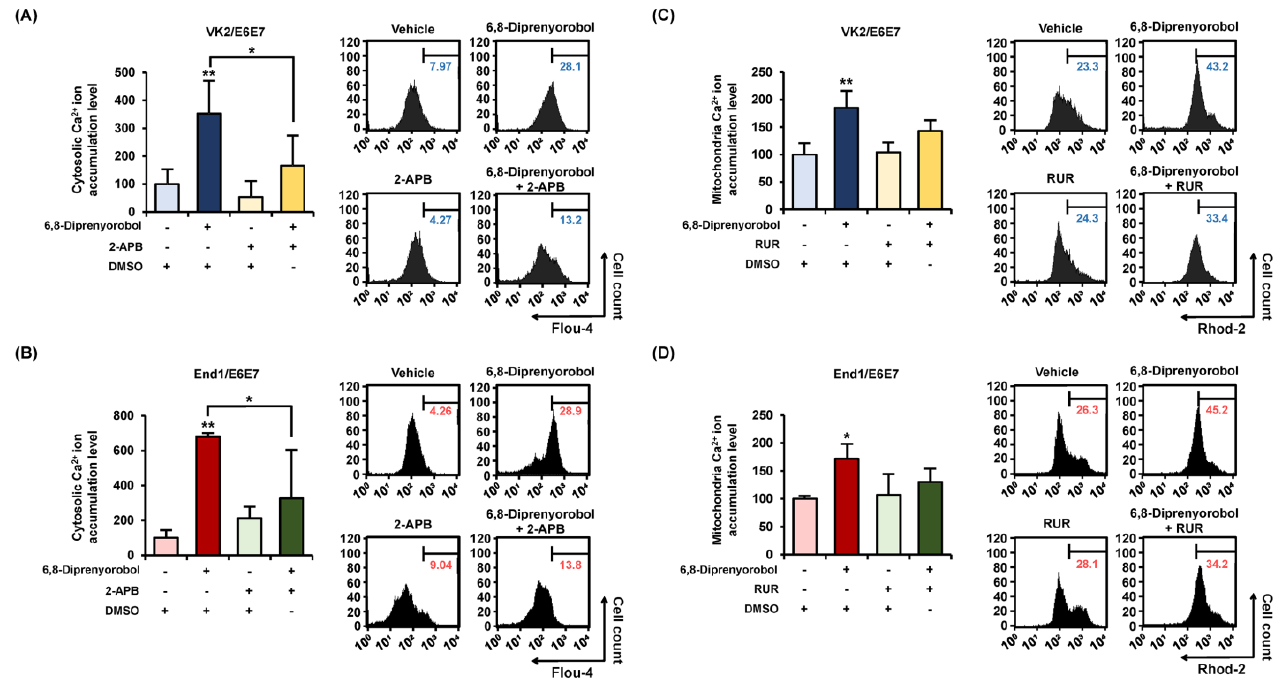
Figure 4. Alleviation effects of 6,8-diprenylorobol on disrupting calcium homeostasis in VK2/E6E7 and End1/E6E7. For 48 h, 6,8-diprenylorobol (2 μM) was treated with or without a calcium inhibitor (2-APB, 5 μM; and ruthenium red, 8 μM). ( A , B ) FACS was adopted to assess the alleviation effects of cytosolic calcium accumulation in human endometriosis cells. ( C , D ) Alleviation effects of the accumulation of mitochondrial matrix calcium was confirmed in human endometriosis cells by FACS. Asterisks indicate significant levels between vehicle-treated cells and 6,8-diprenylorobol-treated cells (* p < 0.05 and ** p < 0.01).